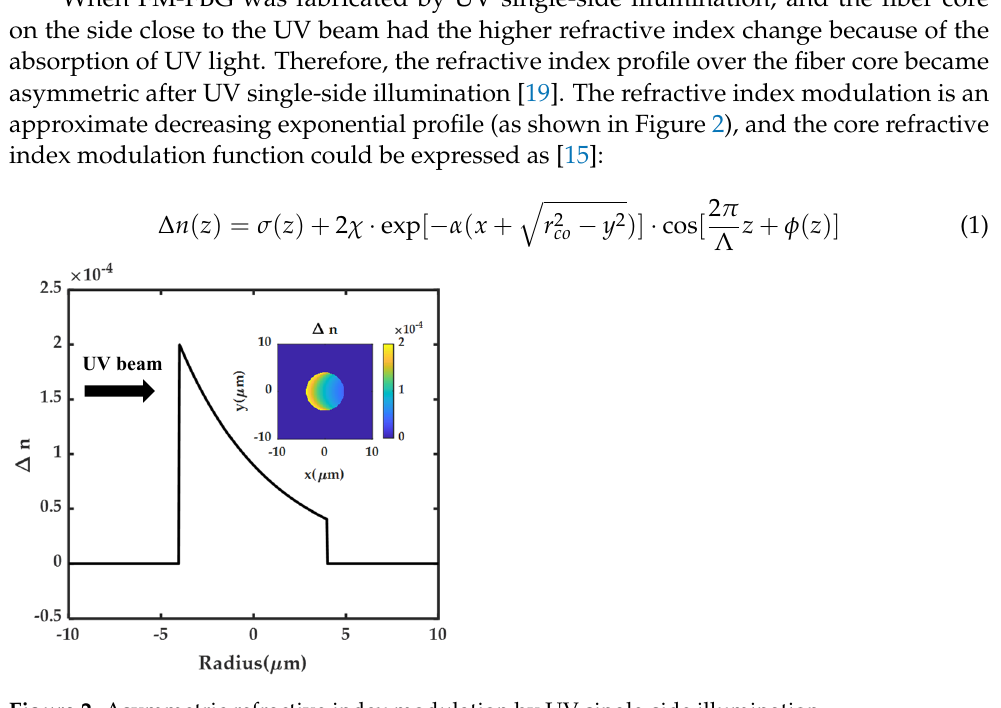
Table 1. The resonance wavelengths of coupled modes under different excitation modes. Excitation Modes–Coupled Modes